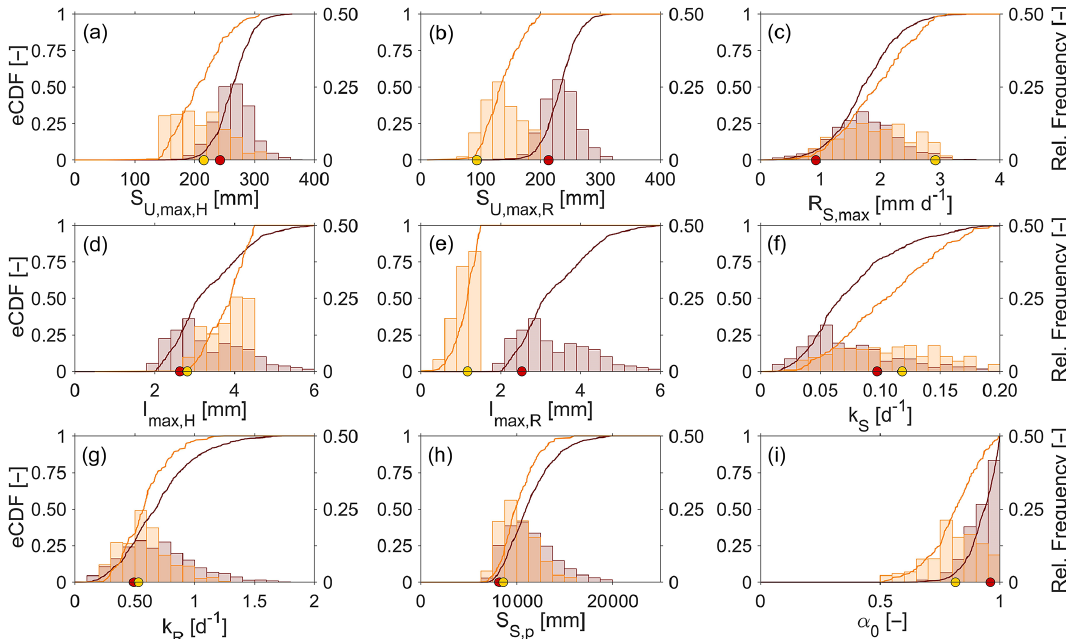
Figure 8. Posterior distributions of selected parameters shown as empirical cumulative distribution functions (lines) and the associated rela- tive frequency distributions (bars). Red shades indicate calibration in the pre-deforestation period. Yellow shades indicate post-deforestation calibration. The dots indicate the parameter values associated with the respective best fit